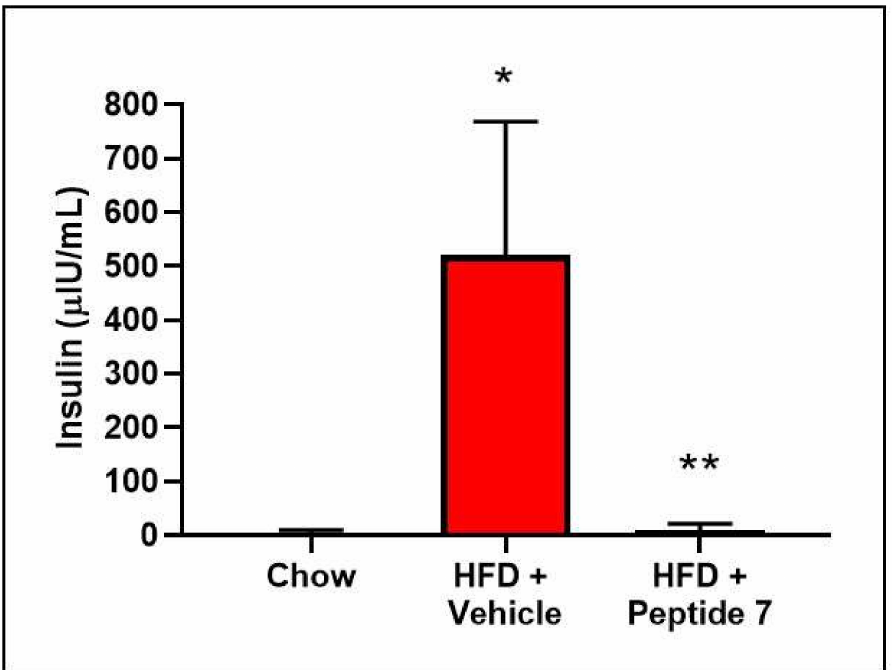
Figure 11. Peptide 7 significantly reduces high fat diet-induced hyperinsulinemia. Mice on a HFD for 10 weeks received either vehicle or Peptide 7 ( n = 4–5 mice/group). * p = 0.0021 (compared to chow), ** p = 0.0023 (compared to HFD + vehicle). Mean ±